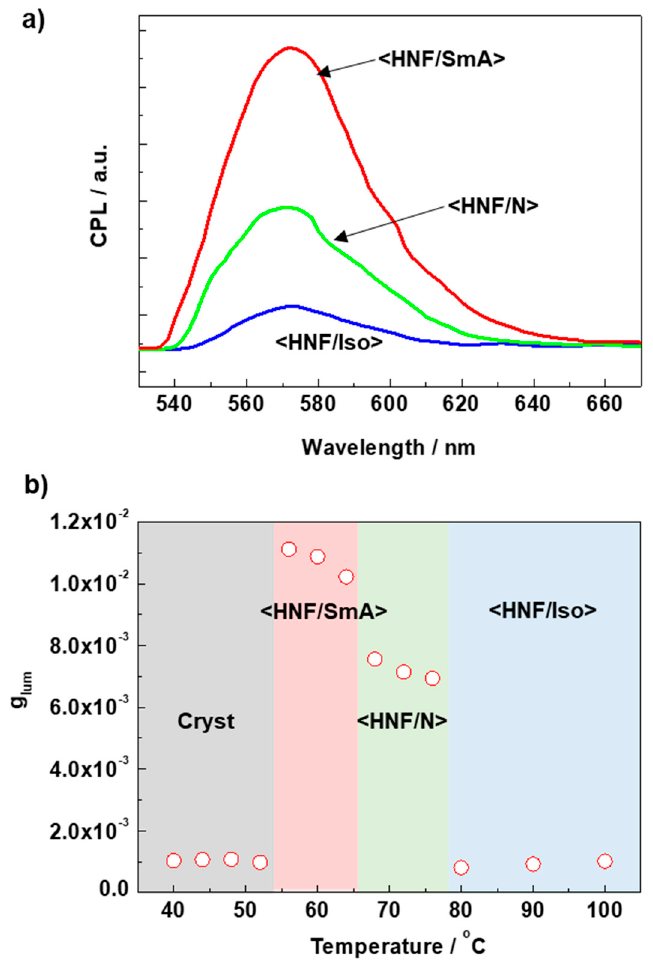
Figure 2. ( a ) Typical circularly polarized luminescence spectra of <HNF/SmA> (58 °C), <HNF/SmA> (75 °C) and <HNF/Iso> (90 °C). ( b ) g lum values (at 570 nm) at different temperatures. HNF = helical